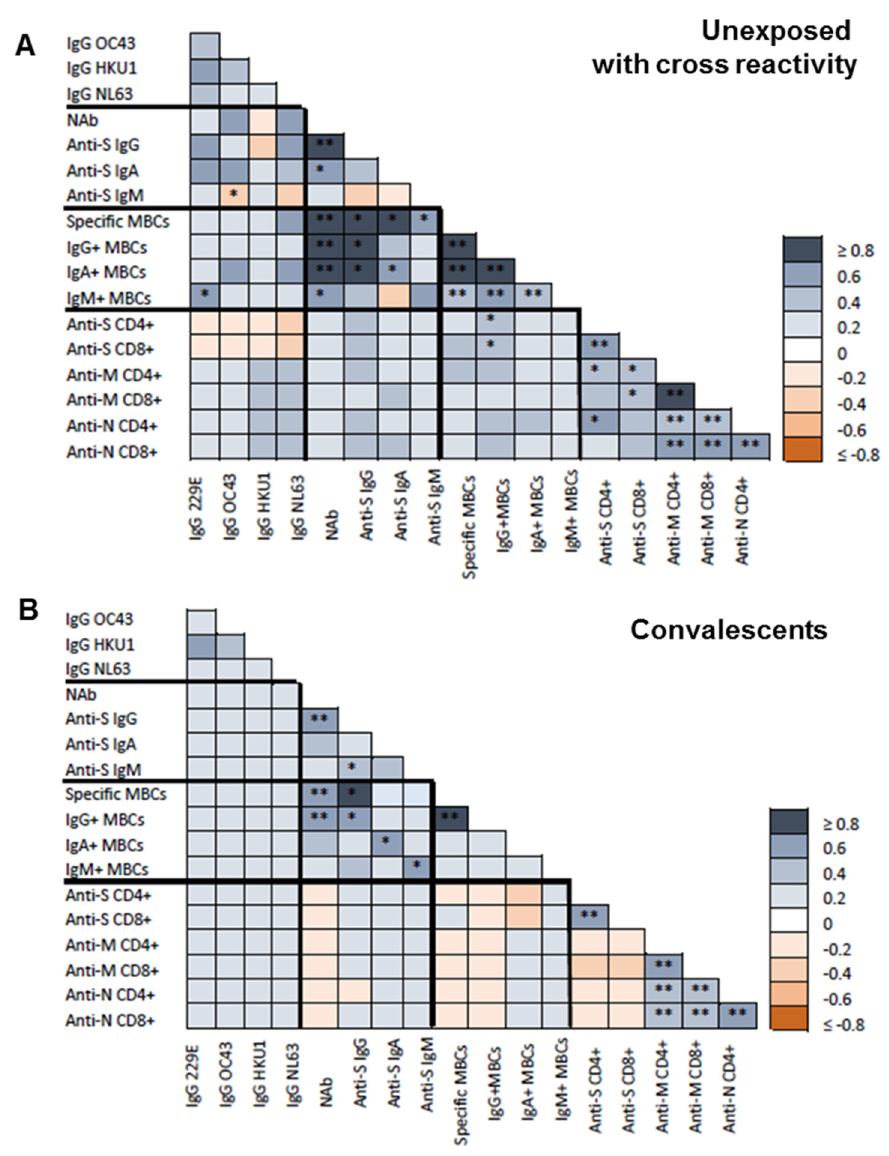
Figure 5. Post-vaccination correlations between antibodies against common human coronavirus (HCoVs), SARS-CoV-2 spike-specific (IgG, IgA, and IgM) antibodies, neutralizing antibodies (NAB), specific memory B-cells (MBCs) and IgG+, IgA+, and IgM+ MBCs isotypes, CD4+ and CD8+ T-cell responses to SARS-CoV-2 spike (S), membrane (M), and nucleocapsid (N) proteins. ( A ), Spearman test heatmap analysis of the different variables in unexposed subjects with cross-reactivity. ( B ), Spearman test heatmap of the different variables in convalescent individuals. The grey color represents a positive correlation and the red color a negative correlation. The intensity of the color indicates the R 2 coefficient. Statistically significant when p < 0.05. * = p < 0.05, and ** = p < 0.01.